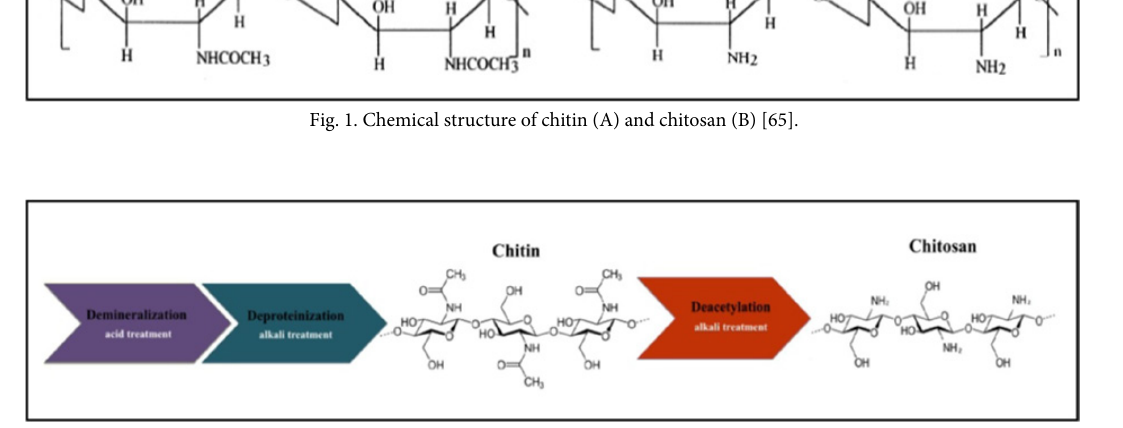
Fig. 2. Extraction process of chitin and chitosan [65].